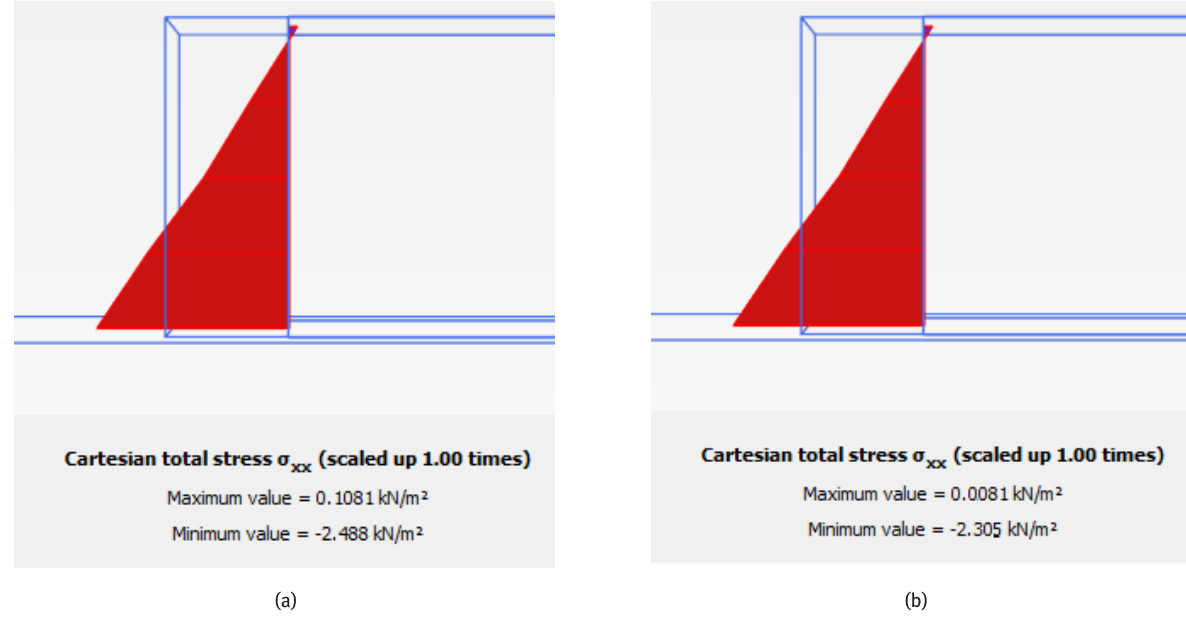
: (a) Prototype; (b) Scaled model. (Plaxis notation for the sign). Figure 3: Total horizontal stress σ xx